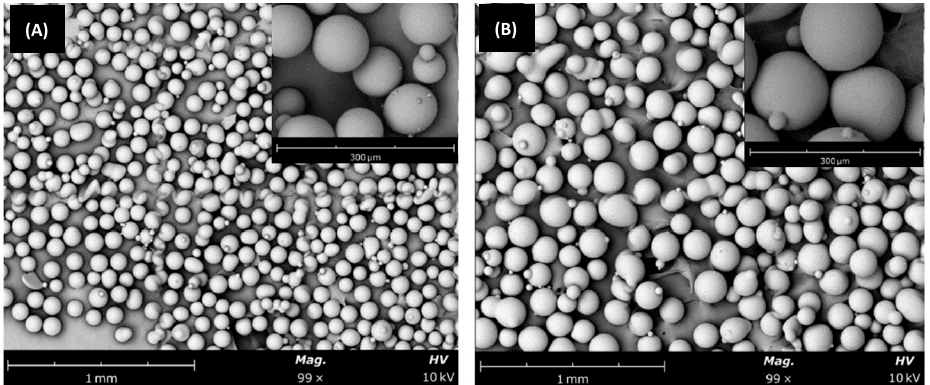
Figure 4. SEM images of the Coniex glass build powder. ( A ) Fine, and ( B ) rough. The compositions and properties of these powders are detailed in Table 1. Table 1. Glass powder composition and properties. Data compiled from [30,38,39].